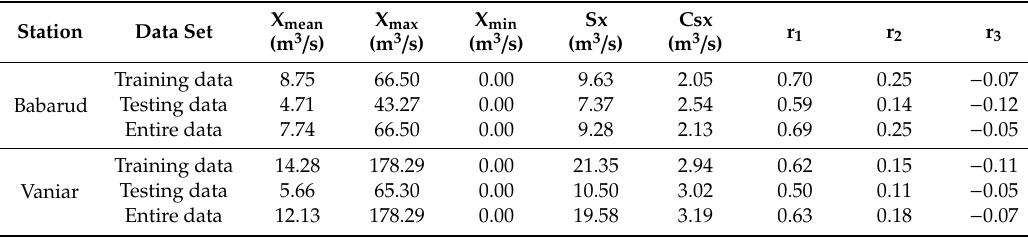
Figure 1. Babarud and Vaniar stations, located at Lake Urmia Basin [37]. Table 1. Statistical parameters of the implemented data (X mean , X max , X min , Sx, Csx, a 1 , a 2 , a 3 denote the overall mean, maximum, minimum, standard deviation, skewness, lag-1, lag-2, lag-3 auto-correlation coefficients, respectively).